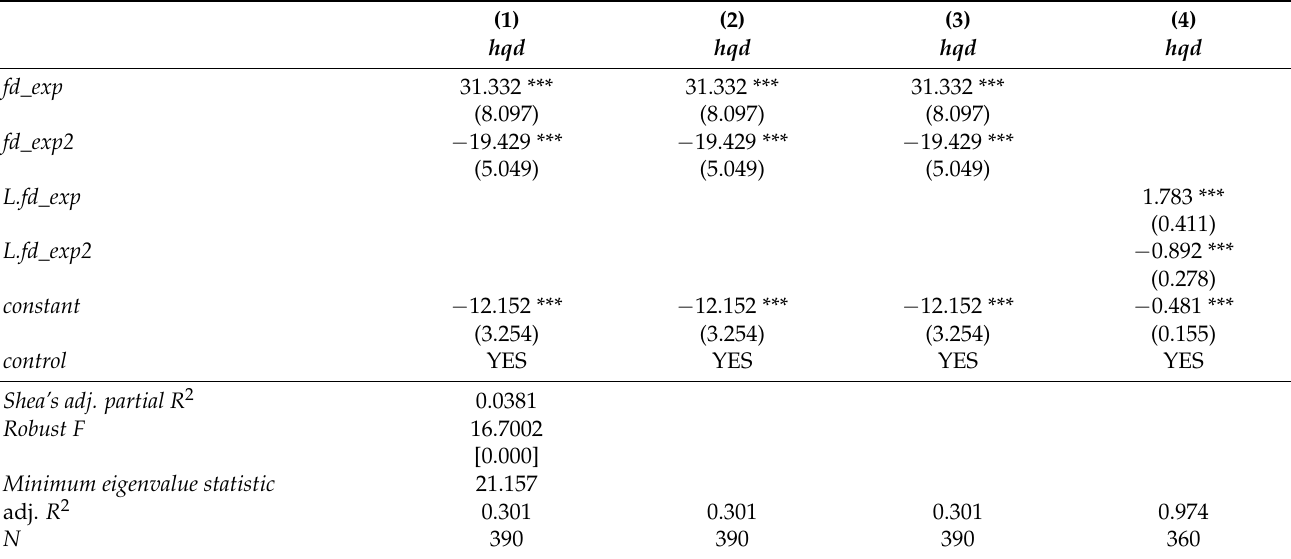
Table 6. Endogeneity